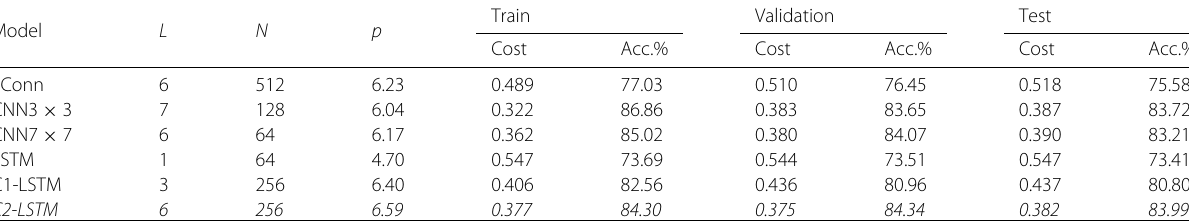
Table 4 Speech event detection results with different network architectures Model